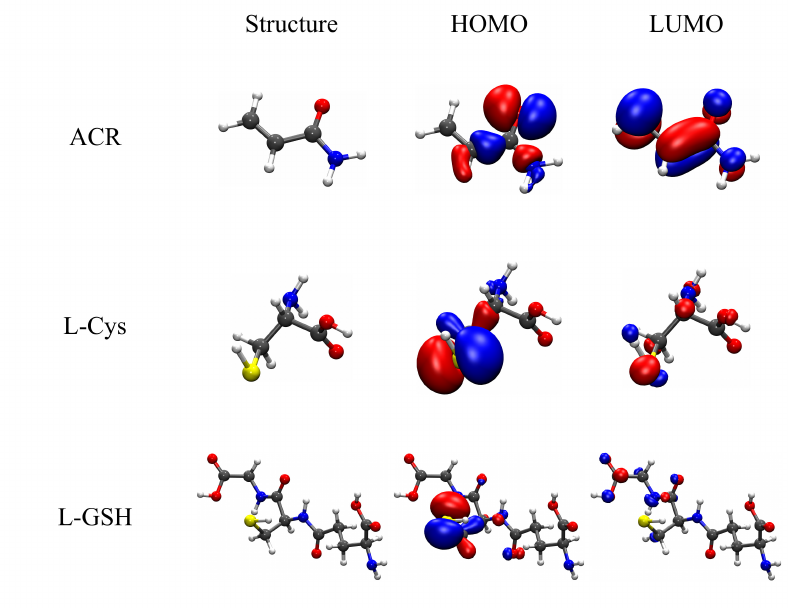
Figure 3. Frontier molecular orbitals of the calculated and studied compounds.